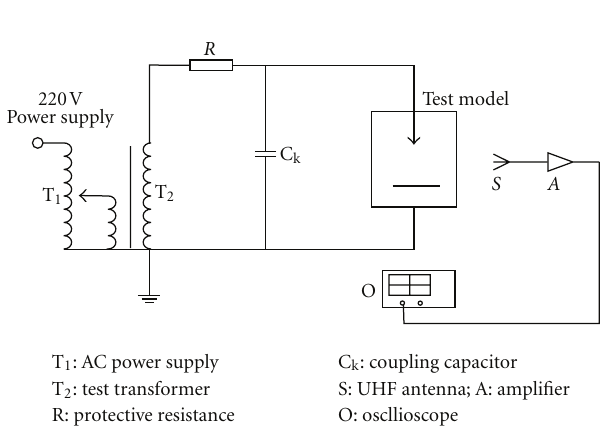
Figure 10: The PD experiment setup in laboratory.